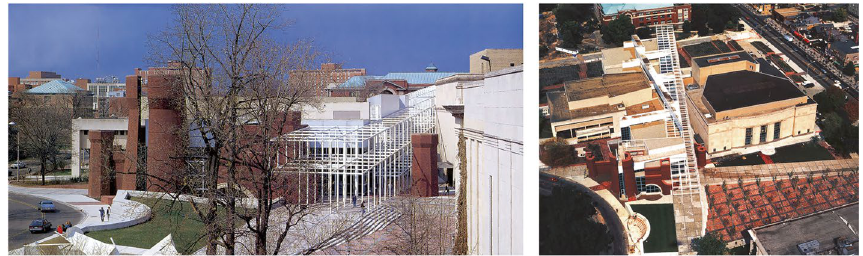
Fig. 1 Wexner Centre for the Performing Arts, The Ohio State University, Columbus, OH. Peter Eisenman Associates architects (Source: Columbia University Avery Library)